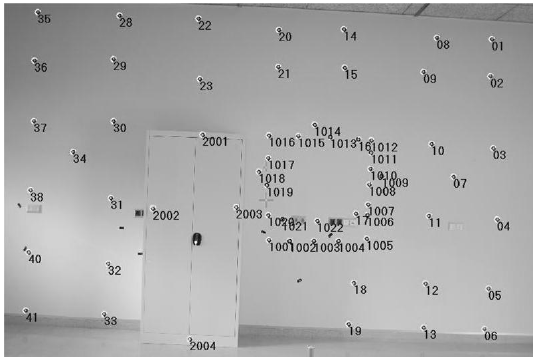
Figure 2. The wall with the distribution of targets used in the case